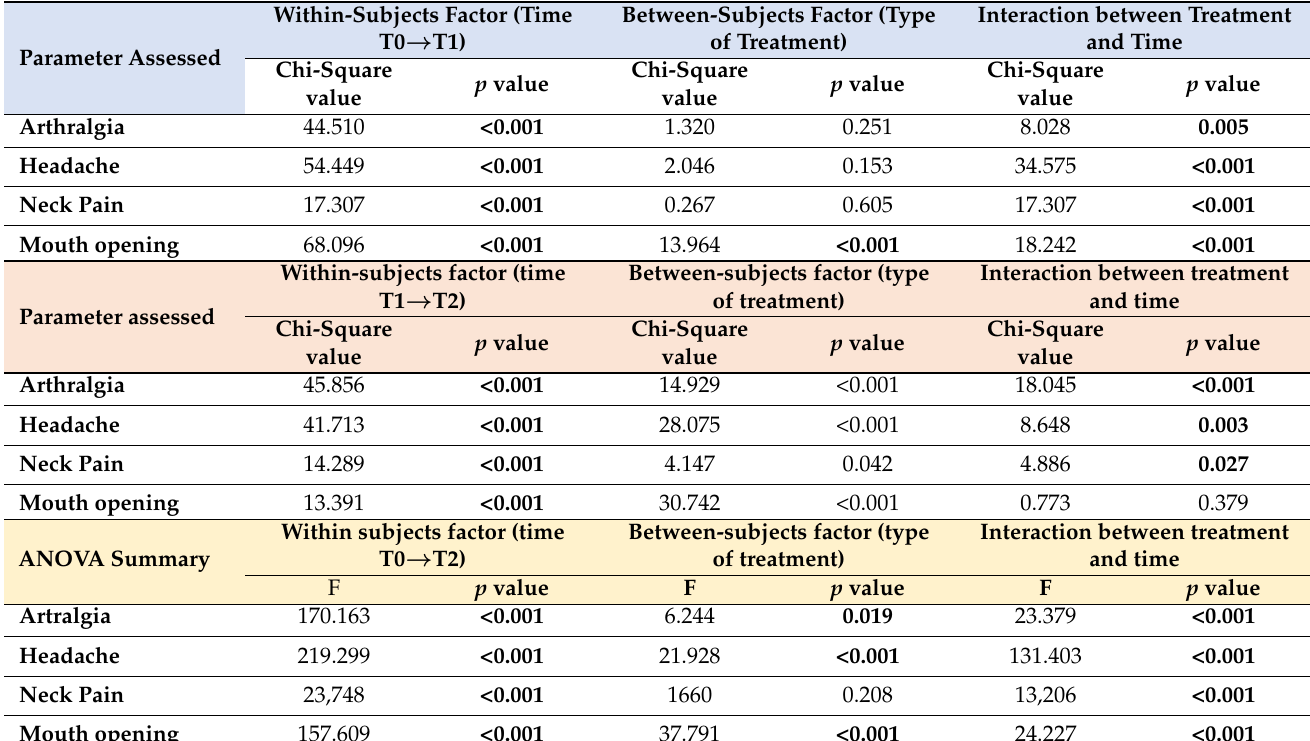
Table 3. Generalized linear mixed model (GLMM) with ANOVA summary for within- and between- subject factors, with statistical significance set at p <